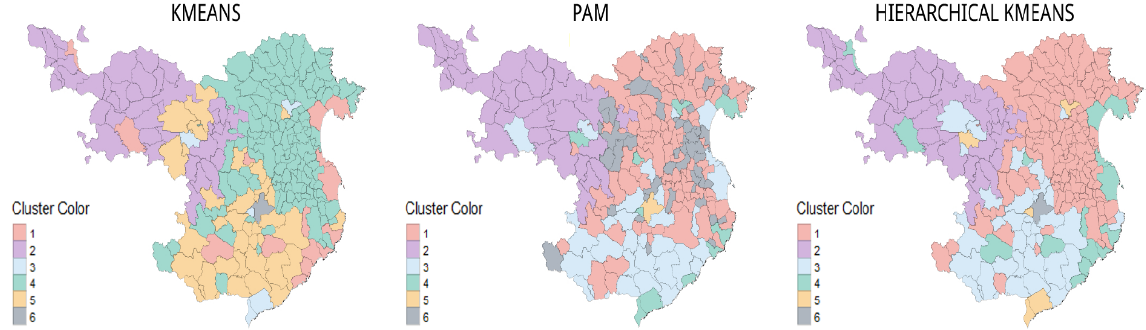
Figure 6. Representation of the cluster map: k-means, PAM, and hierarchical k-means, according to the nominal dataset, to observe their spatial distribution. Source: authors’ own elaboration.